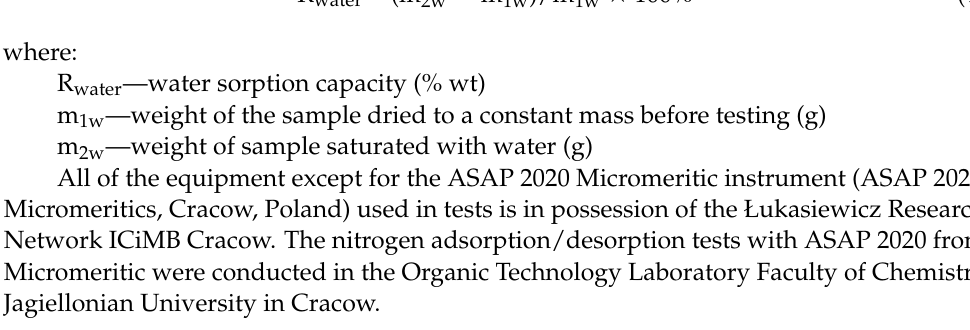
feed compaction zone